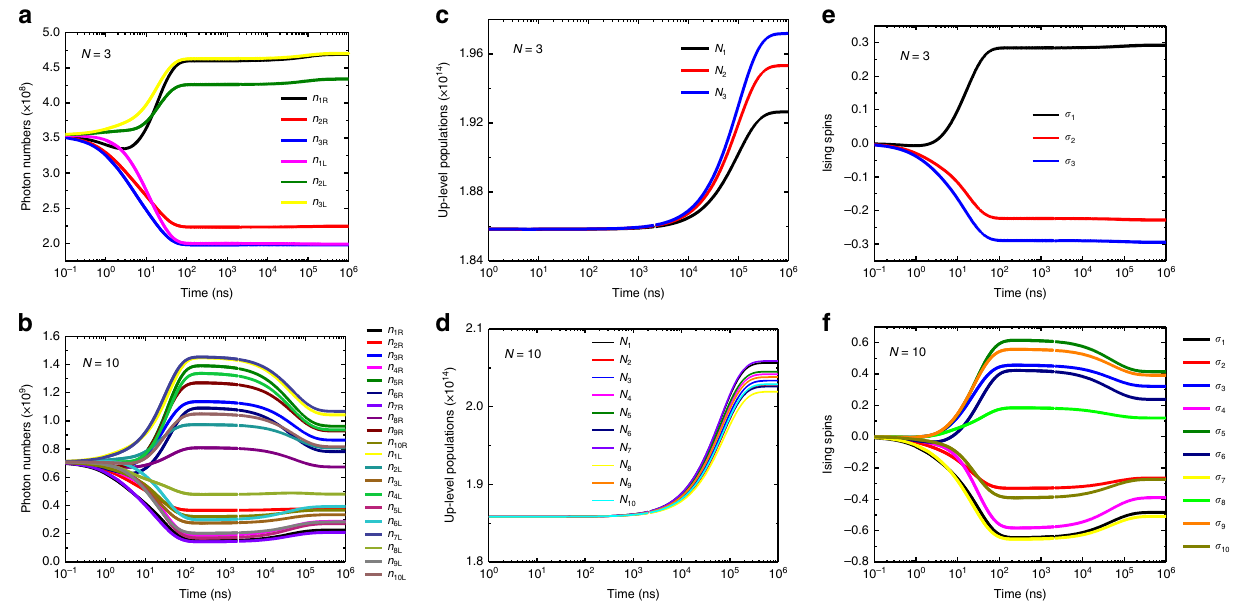
Fig. 2 Simulation results. Time dynamic of a network of injection-locked MCF lasers for N = 3 (left column) and N = 10 (right column). The time evolution analyses are plotted in the log format for a , b photon number in right and left circular polarizations, c , d up-level population, and e , f computed Ising spins. The calculated Ising spin signs for N = 3 and N = 10 correspond to the ground state spin con fi guration of introduced Ising Hamiltonians